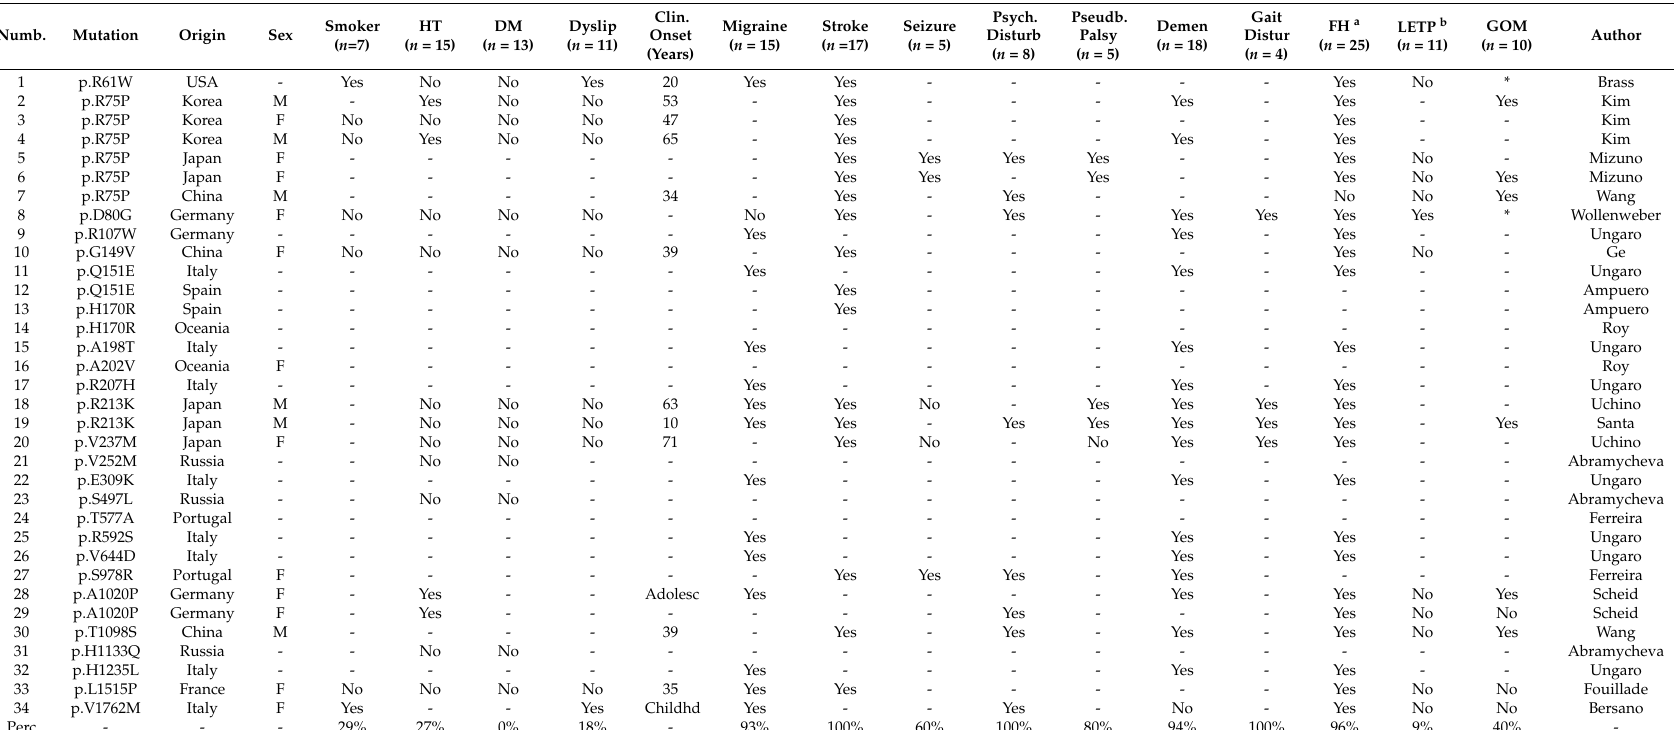
Table 2. Clinical and demographic data of the patients with cysteine-sparing NOTCH3